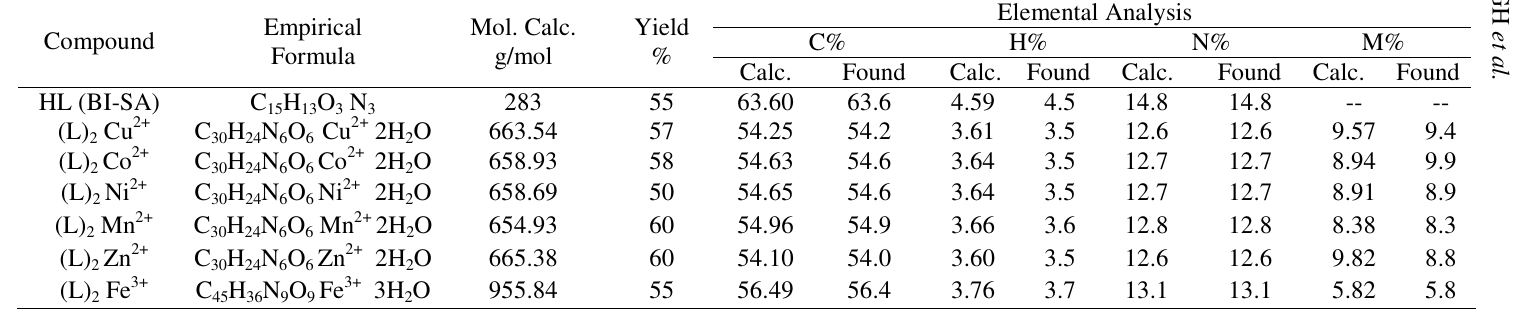
Table 1. Analytical data of the metal chelates of HL